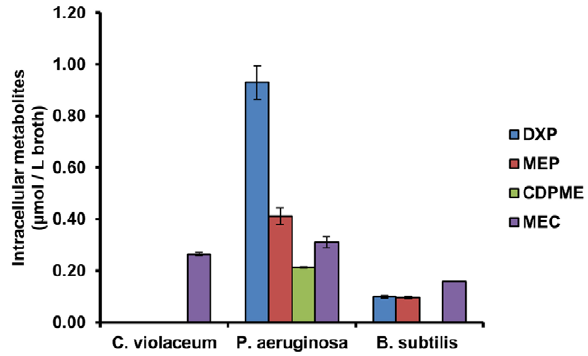
pathway intermediates at middle exponential growth phase. Presented data were average of triplicates and standard errors were drawn on the plot. C. violaceum : Chromobacterium violaceum; P. aeruginosa : Pseudomonas aeruginosa; B. subtilis : Bacillus subtilis .